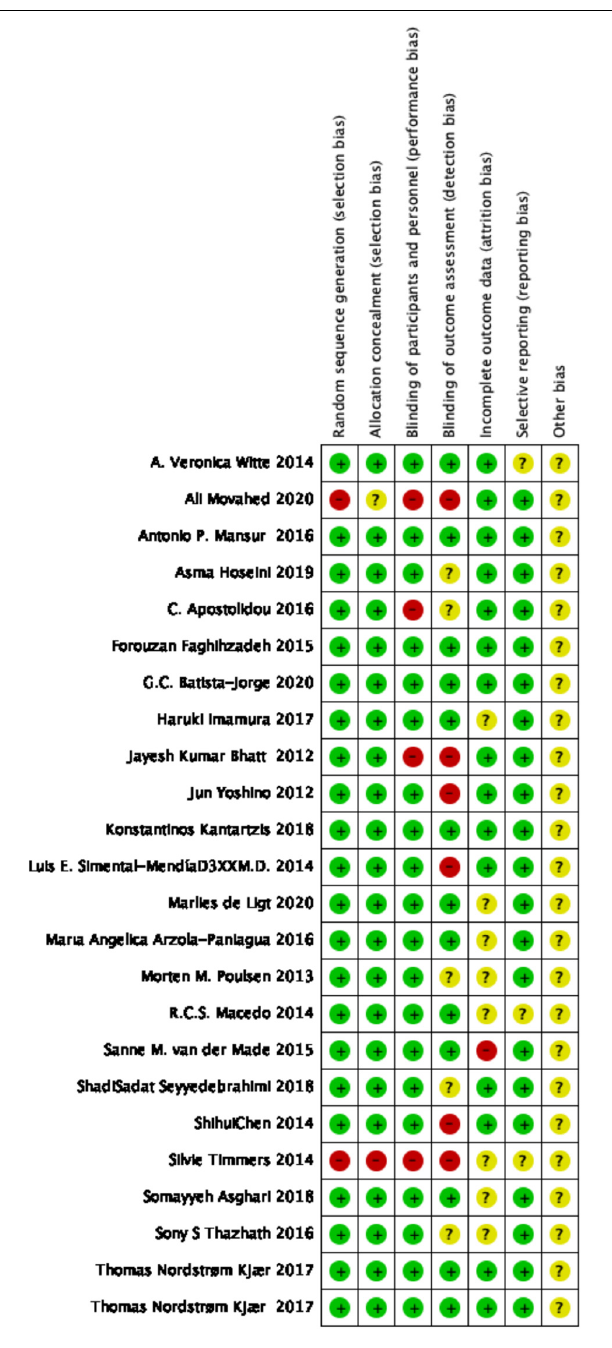
FIGURE 2 | The methodological quality of included studies (risk of bias).